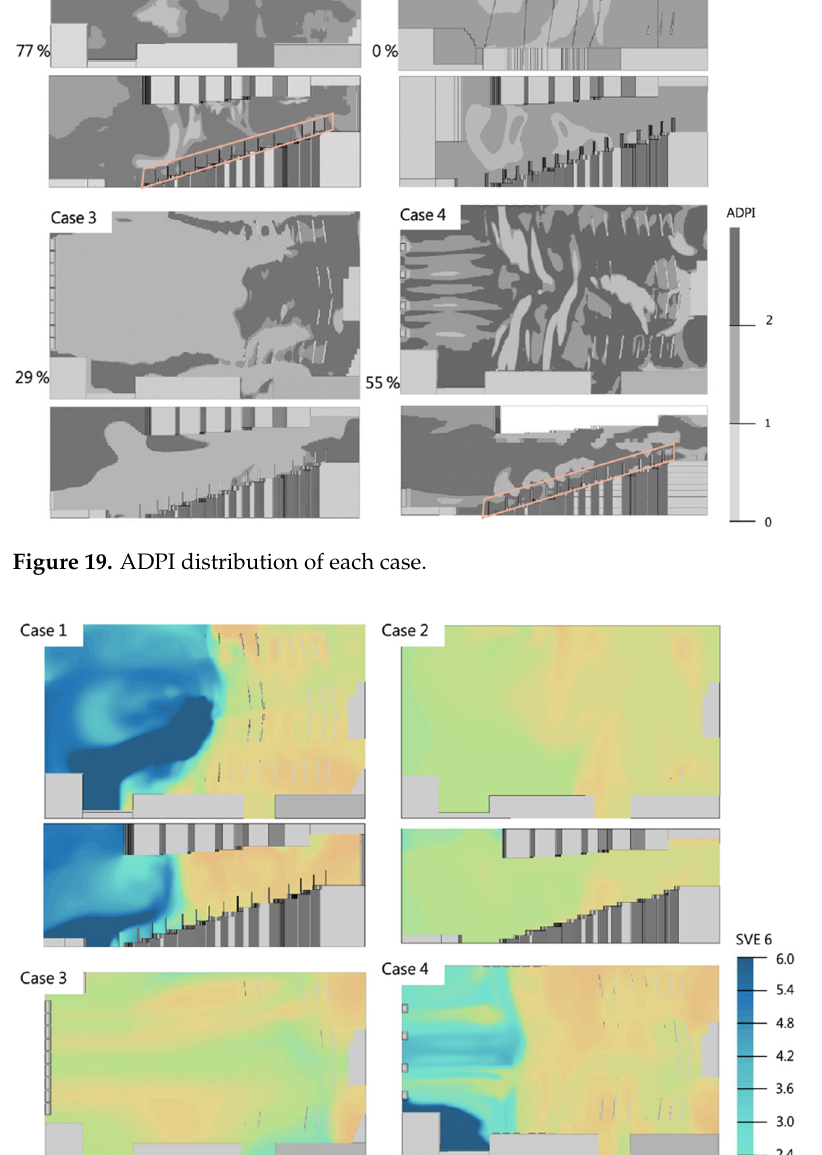
Figure 18. EDT distribution of each case.